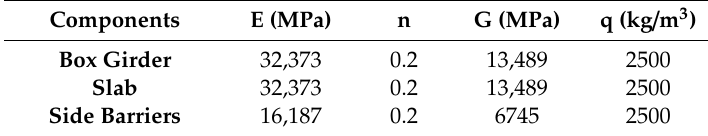
Table 2. Material properties of the initial FE model.